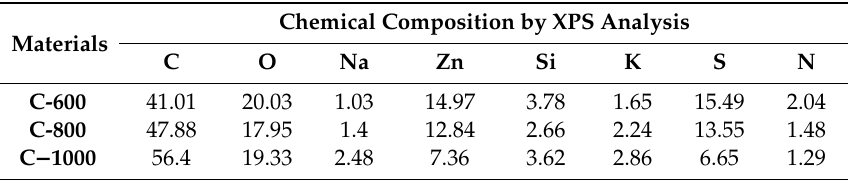
Table 2. Chemical composition of carbon residue after heat treatment of latex in a horizontal tube furnace for 15 min at three di ff erent temperatures.